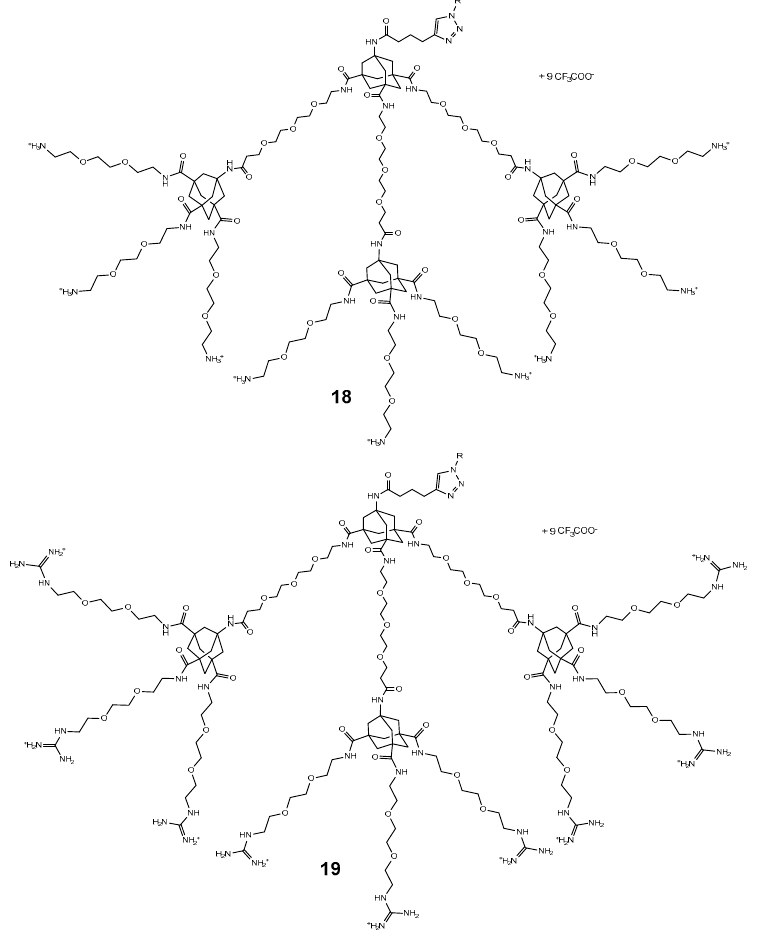
Figure 10. Polycationic adamantane-based dendron (HYDRAmers) with ammonium ( 18 ) and guanidinium groups ( 19 ) for complexation with DNA.